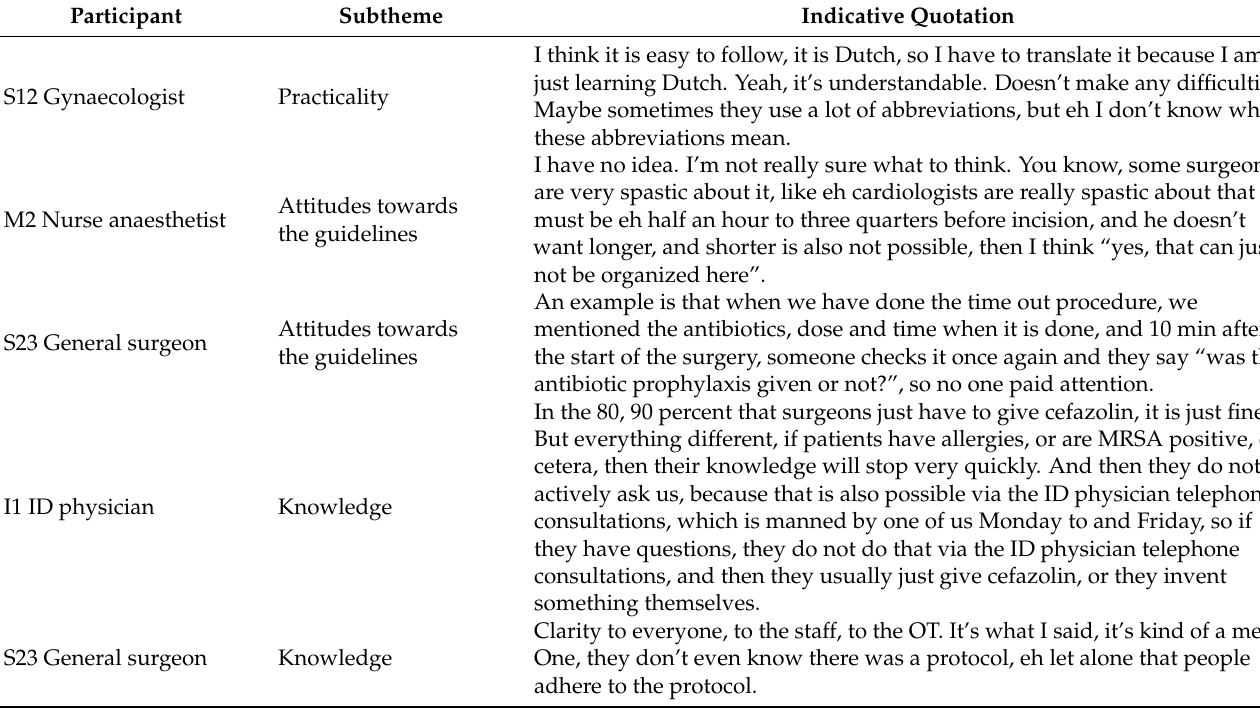
Table 3. Guideline factors: Indicative